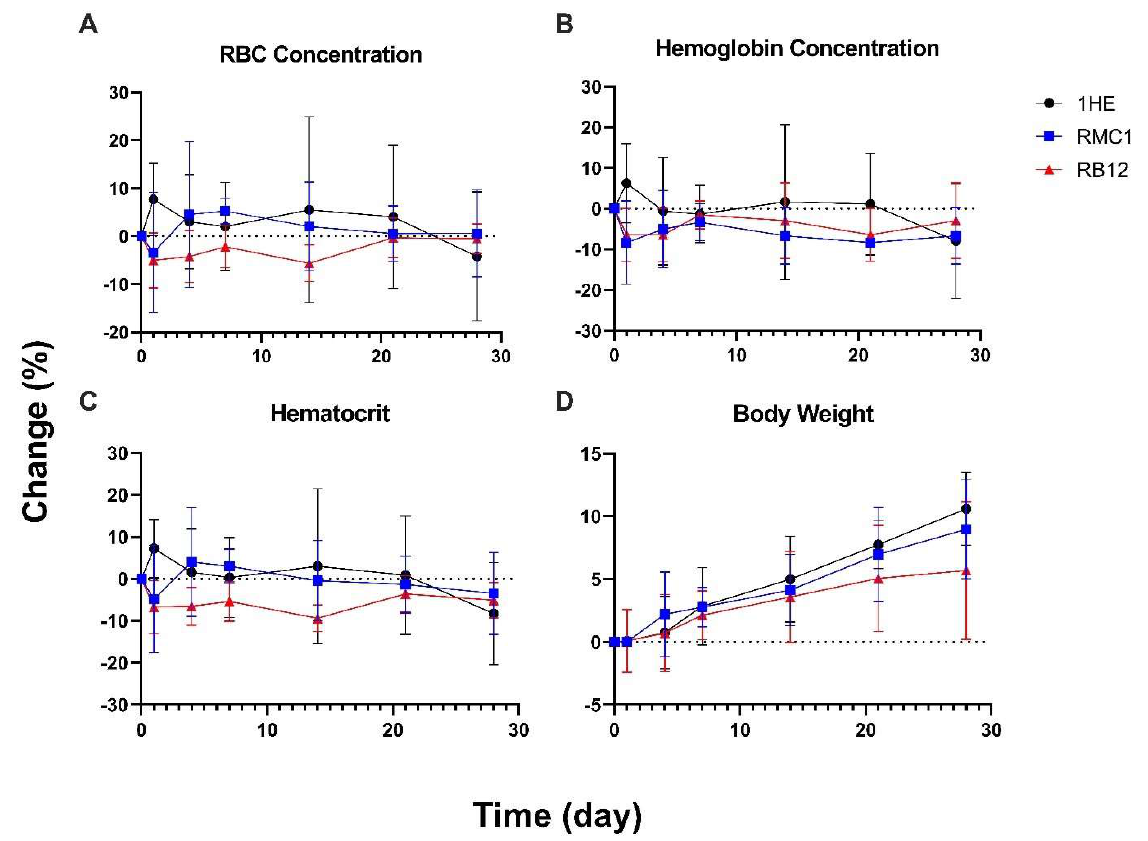
Figure 6. Hematology study of anti-RBC sdAbs. Two-way repeated measures ANOVA was utilized to evaluate the effect of time, treatment (administration of anti-RBC sdAbs), and their interaction on ( A ) RBC concentration, ( B ) hemoglobin concentration, ( C ) hematocrit and ( D ) mouse body weight. There seems to be significant interaction between the effect of time and treatment with RB12 on hematocrit ( p = 0.0155). Otherwise, the administration of RMC1 and RB12 at the high dose of 5 mg/kg did not result in a significant change in the hematological parameters and body weight in Swiss Webster mice compared with the control sdAb 1HE. Data points represent the mean plasma concentration ( n = 3), and error bars denote the standard deviation of the mean.